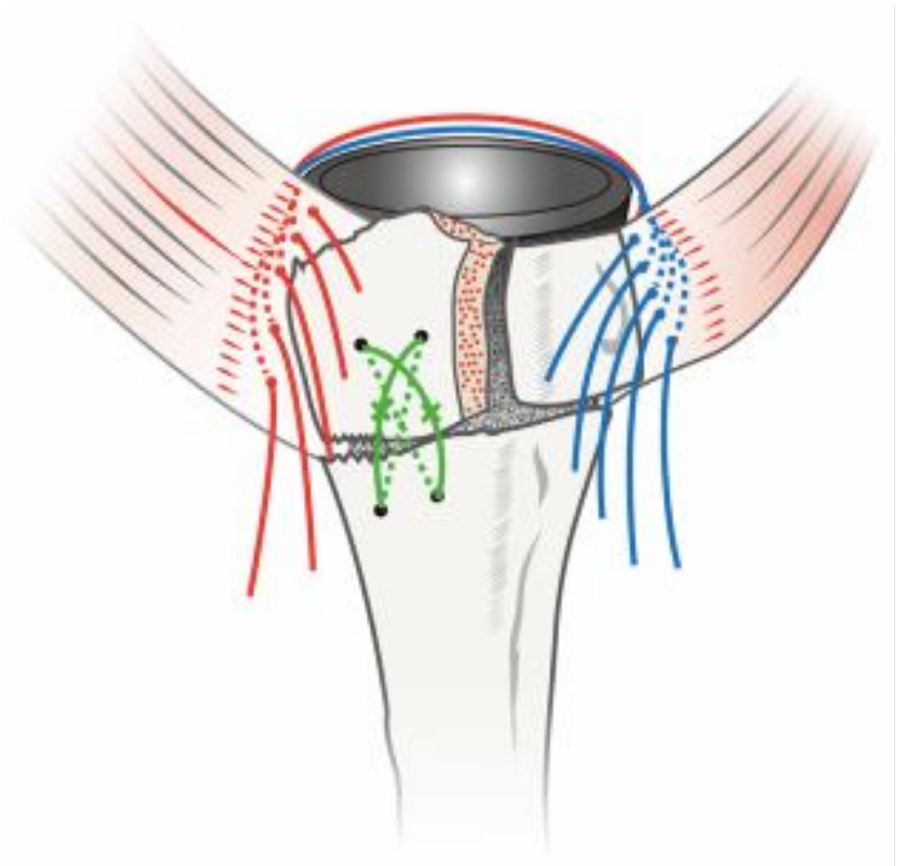
Figure 4. Turned suture tension band technique. Five sutures are passed through the suture hole of the humeral stem. Five sutures are turned clockwise and the other five are turned counter clockwise around the stem. Reprinted with permission from [82]. Copyright year 2021.